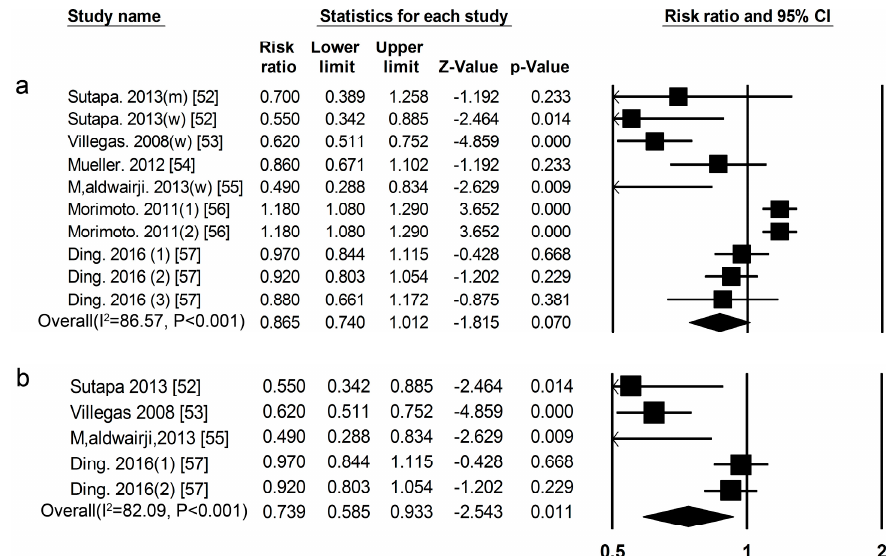
Figure 9. Soy and type 2 diabetes RRs for ( a ) the highest vs. the lowest intake in all subjects and ( b ) the highest vs. the lowest intake in women. The RR of each study is represented by a square, 95% CI are represented by the horizontal lines, and the diamond represents the estimate and its 95% CI.